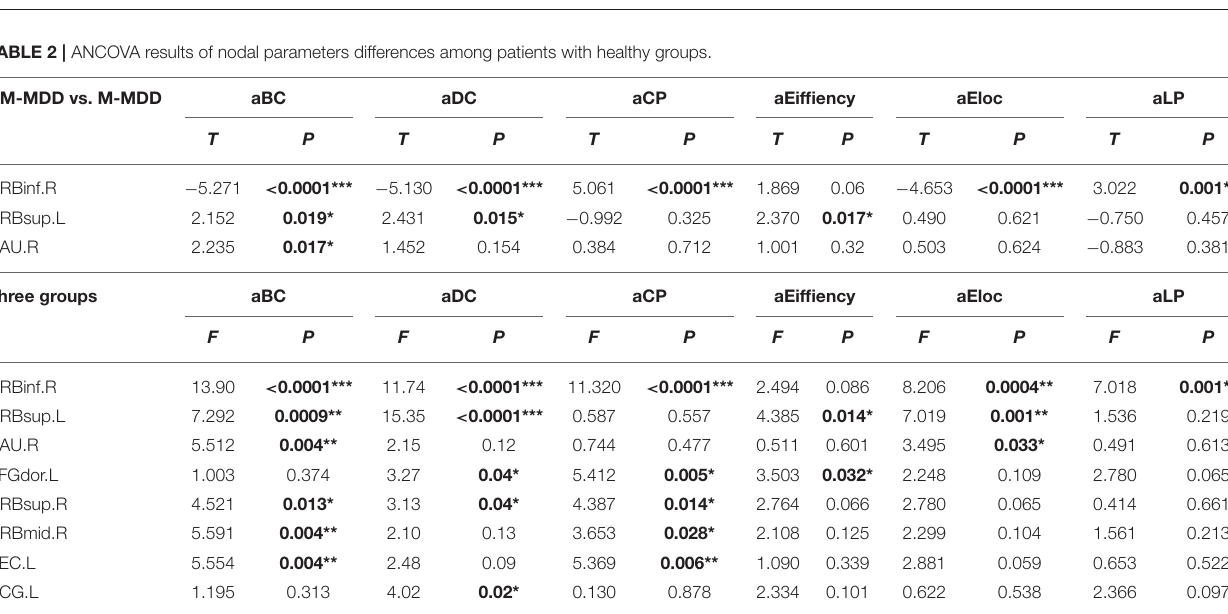
FIGURE 1 | Group comparison of small-world network measures among NM-MDD, M-MDD, and control groups. MDD groups showed significantly decreased σ , γ , clustering coefficient, and global efficiency; M-MDD group showed significantly decreased local efficiency and increased characteristic path length ( p < 0.05, FDR corrected). σ , small-worldness; λ , normalized characteristic path length; γ , normalized clustering coefficient. * p < 0.05; ** p < 0.005.